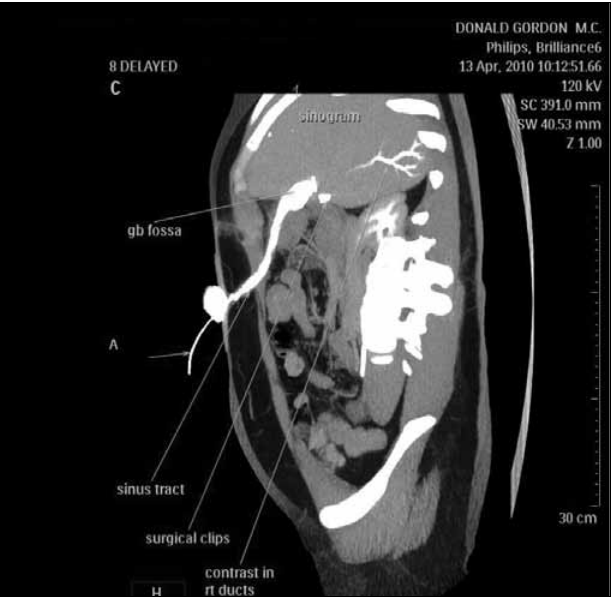
Fig. 1. Reconstructed CT sinogram demonstrates contrast filling the sinus tract, gallbladder fossa and the right posterior sectoral ducts.